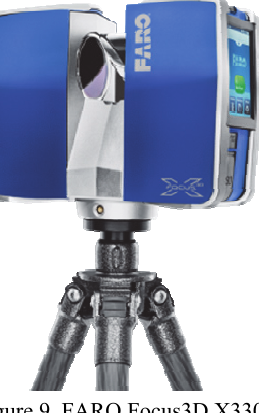
Figure 9. FARO Focus3D X330